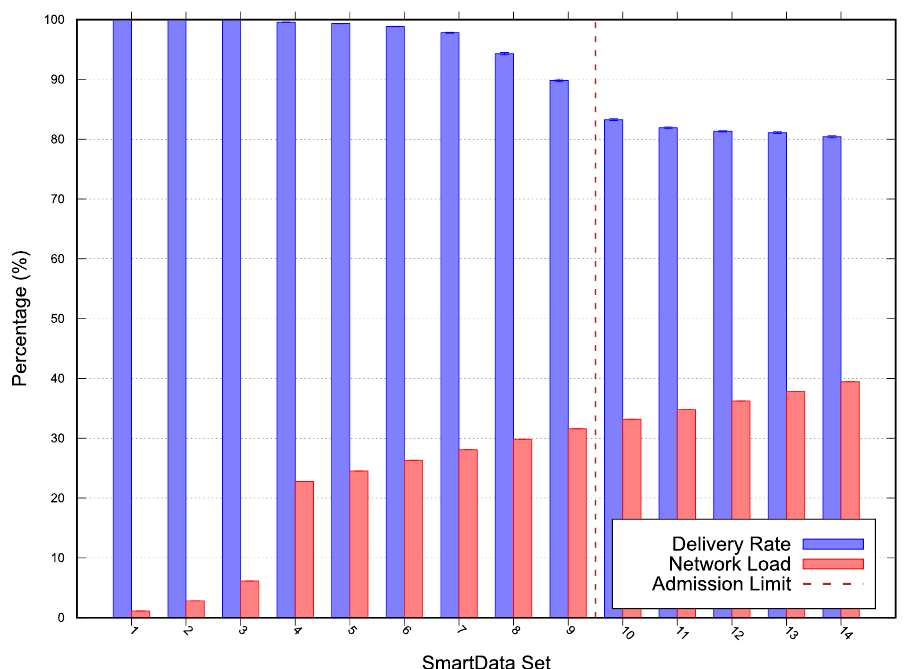
Figure 4. Scenario 1 simulation and scalability results—Error with 95% Confidence Interval (CI).